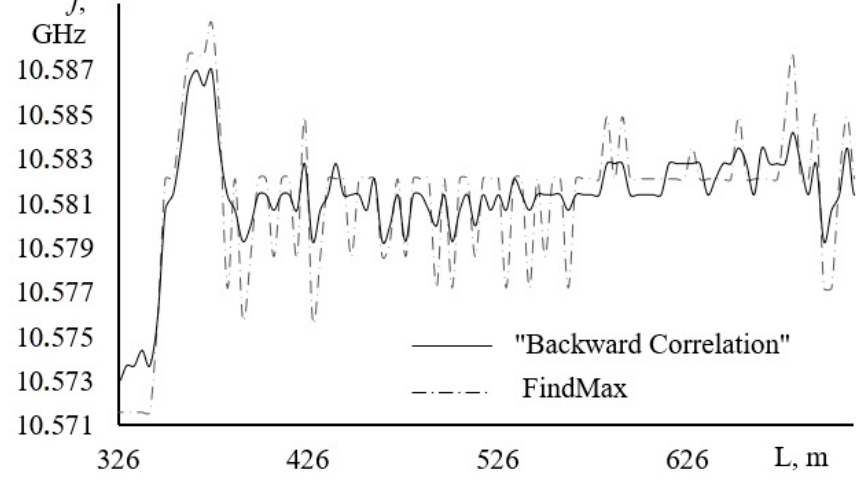
Figure 4. Comparison of the results of the two methods on a real Brillouin optical time domain analyzers (BOTDA) trace.